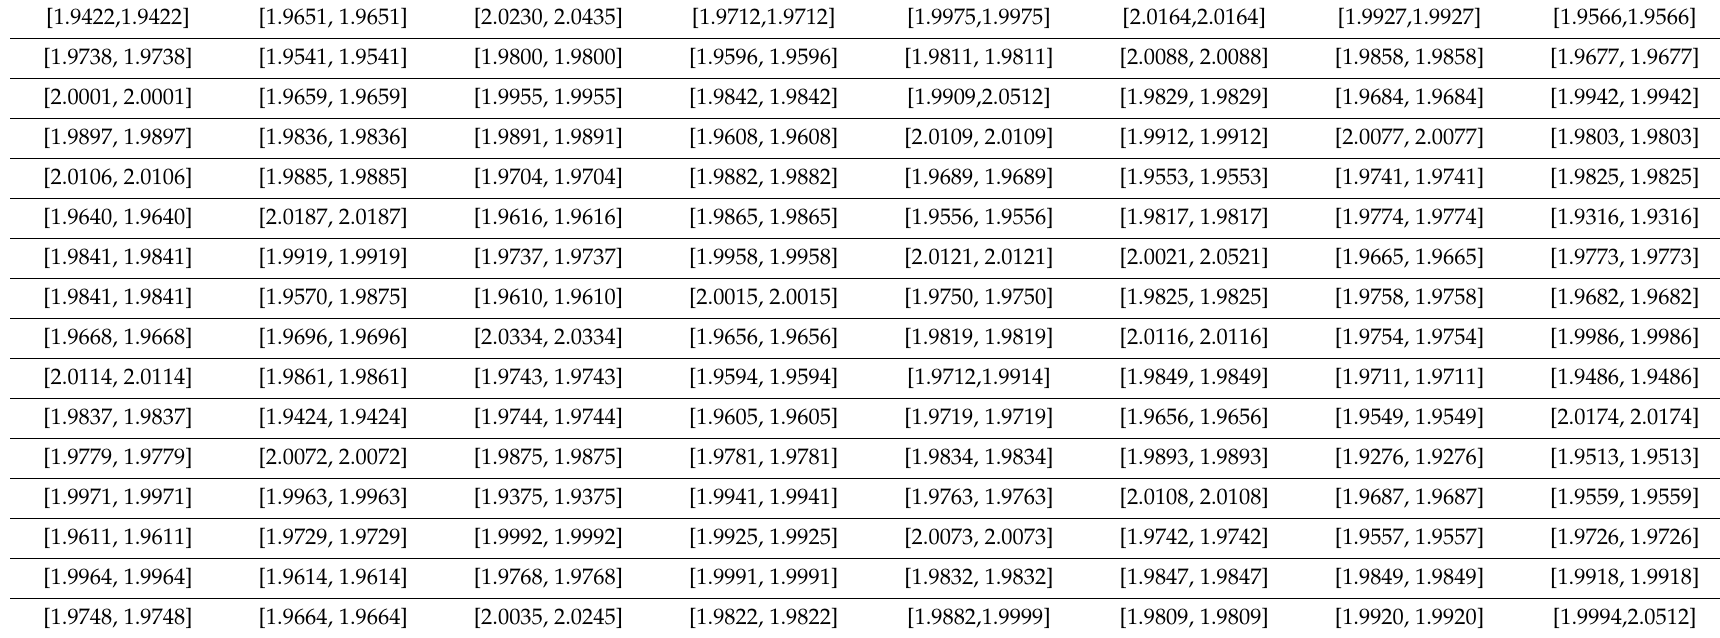
Table 3. Indeterminate data of Amplified Sensors from